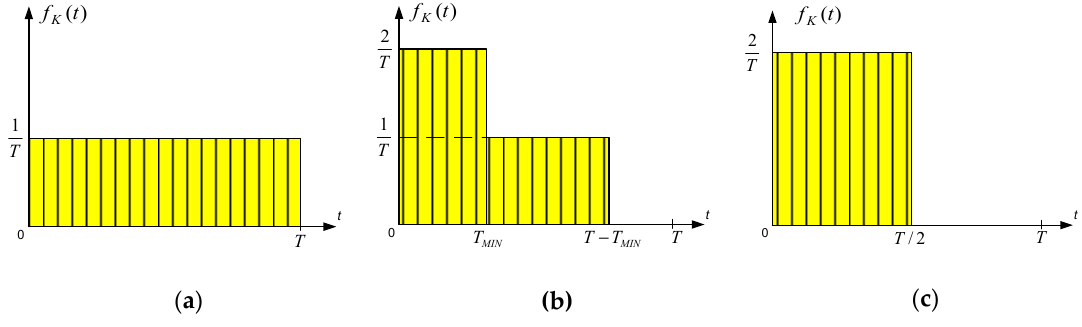
Figure 1. Graphs of probability density functions (PDFs) for the travel time of semi-random trip. ( a ) In the case where 𝑘 = 0 or 𝑘 = 𝑇 . ( b ) In the case where 𝑘 ∈ (0, 𝑇) . ( c ) In the case where 𝑘 = 𝑇/2.